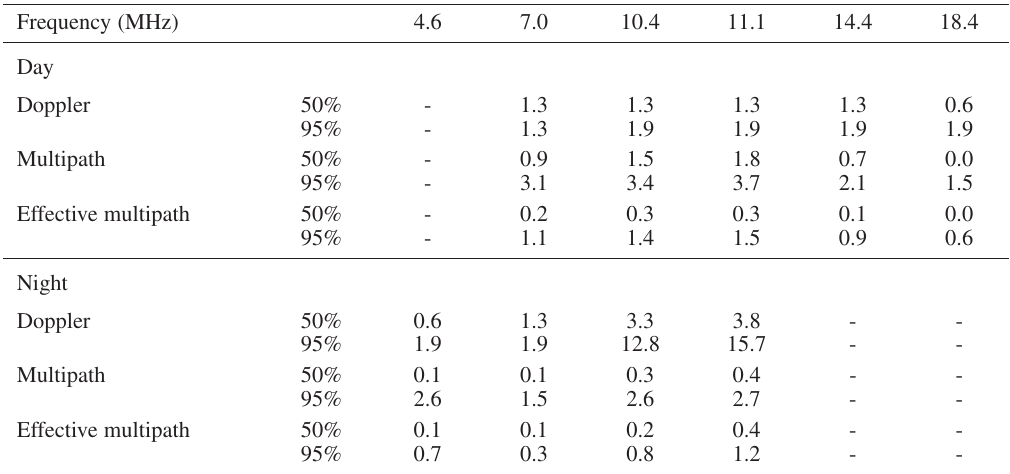
Table 14.II. Median and 95% occurrence values of spreads during winter (November, December and January) day (09:00-15:00 UT) and night (21:00-03:00 UT).